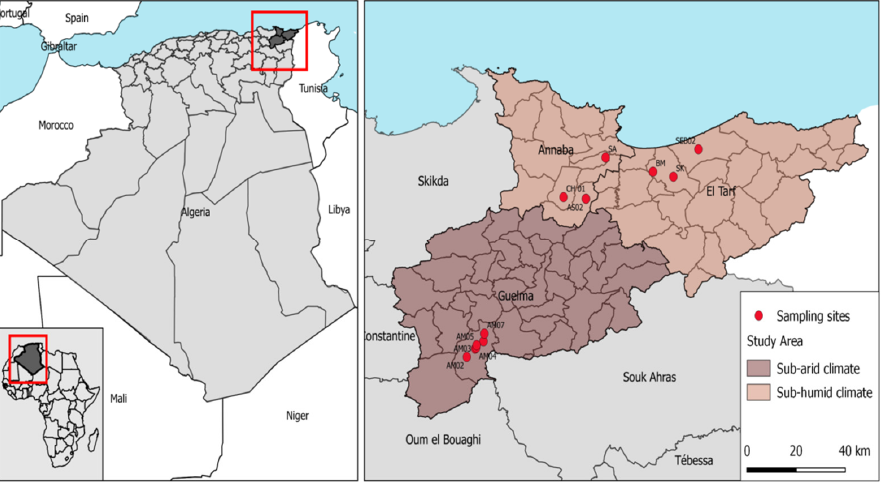
Figure 1. Geographic map of Algeria ( left ) and its study area as well as sampling sites indicating the sub ‐ humid and sub ‐ arid climate ( right ).